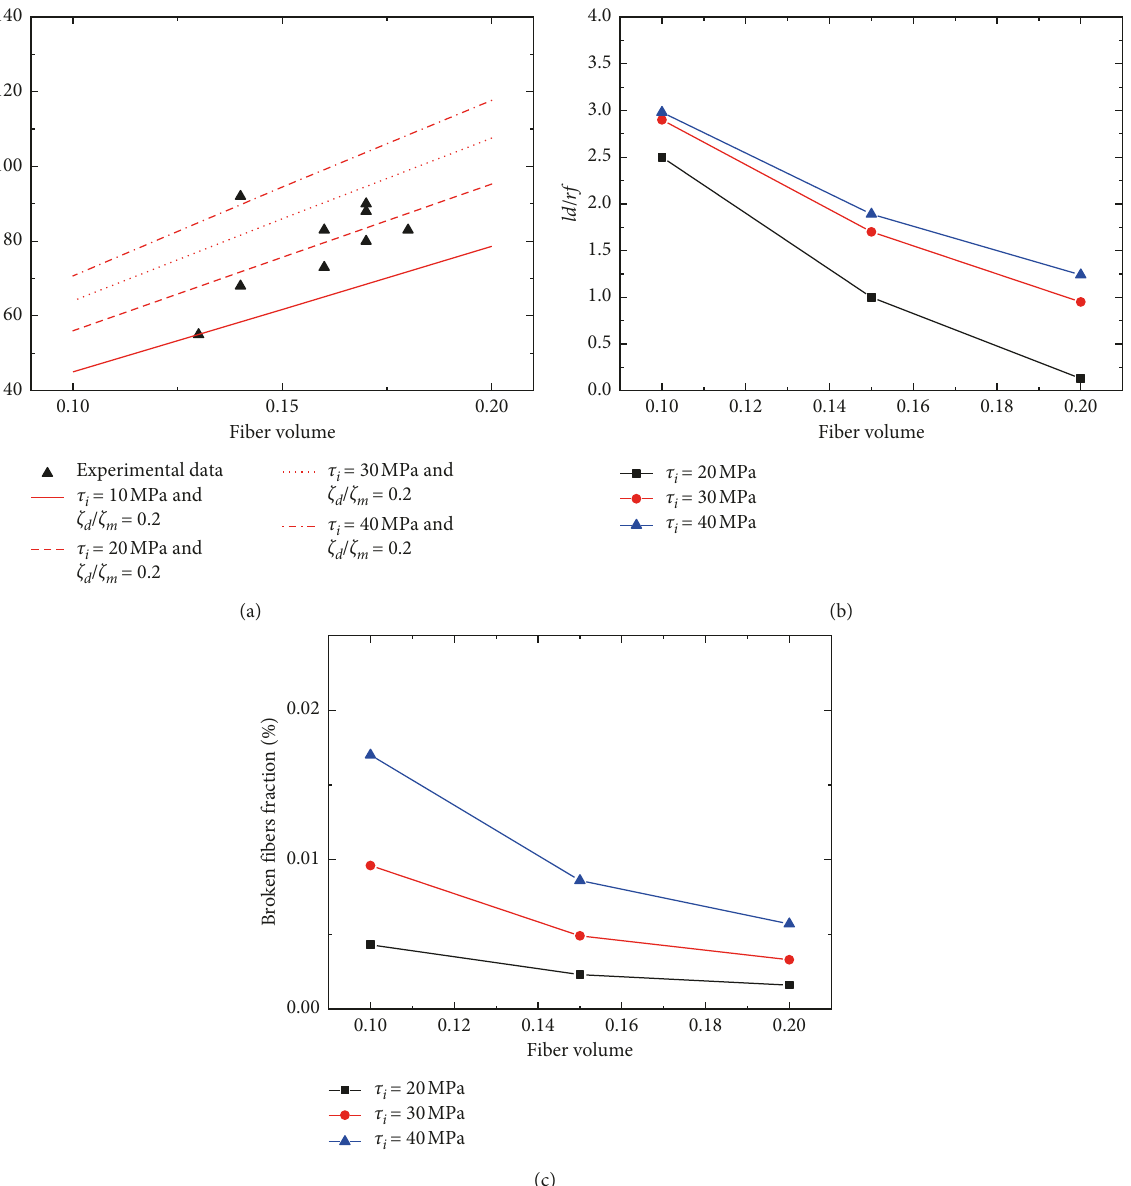
Figure 7: (a) The experimental and predicted first matrix cracking stress versus the fiber volume curves; (b) the interface debonding length versus the fiber volume curves; (c) the broken fibers fraction versus the fiber volume curves of 2D Hi-Nicalon ™ SiC/SiC